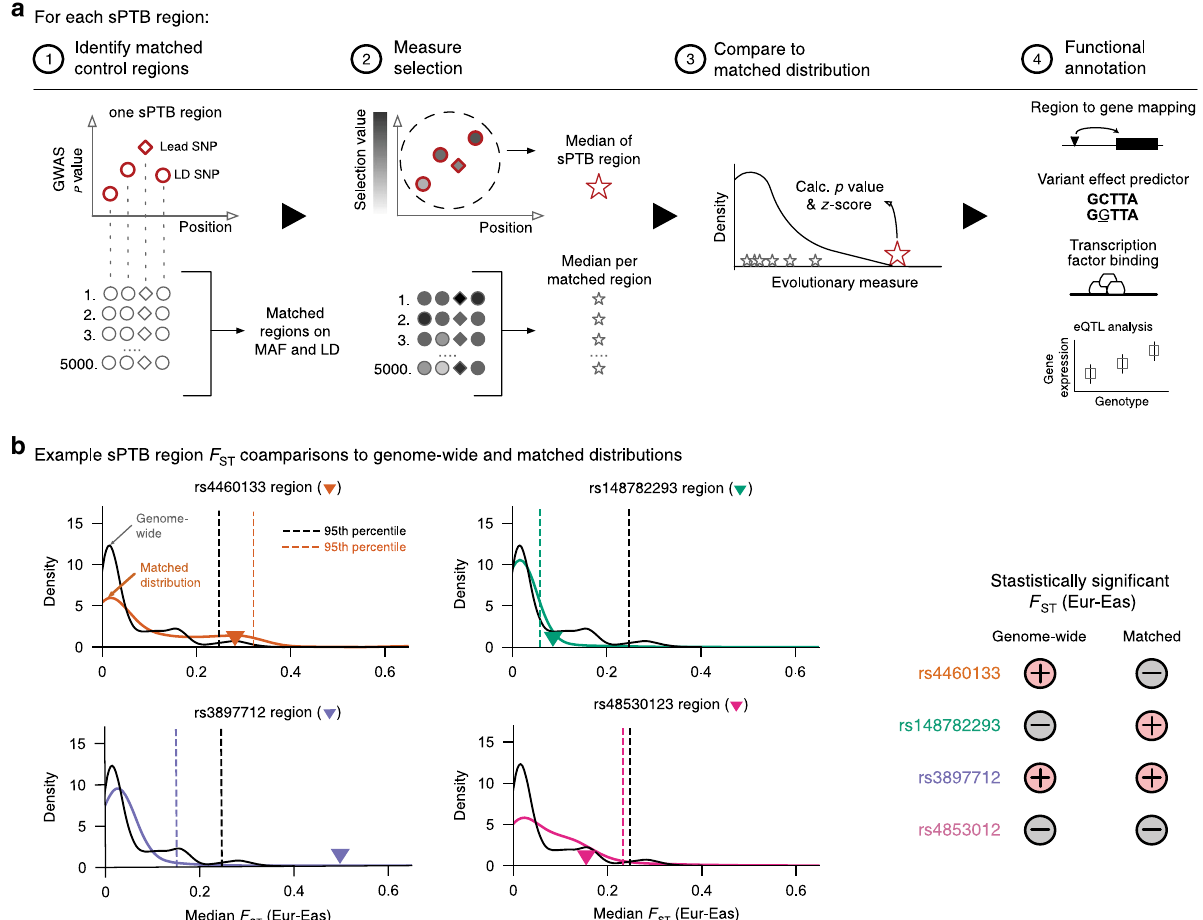
Fig. 1 Framework for identifying genomic regions that have experienced diverse evolutionary forces. a We compared evolutionary measures for each sPTB-associated genomic region ( n = 215) to ~5000 MAF and LD-matched control regions. The sPTB-associated genomic regions each consisted of a lead variant ( p < 10E-4 association with sPTB) and variants in high LD ( r 2 > 0.9) with the lead variant. Each control region has an equal number of variants as the corresponding sPTB-associated genomic region and is matched for MAF and LD ( ‘ Identify matched control regions ’ ). We next obtained the values of an evolutionary measure for the variants included in the sPTB-associated regions and all control regions ( ‘ Measure selection ’ ). The median value of the evolutionary measure across variants in the sPTB-associated region and all control regions was used to derive an empirical p value and z-score ( ‘ Compare to matched distribution ’ ). We repeated these steps for each sPTB-associated region and evolutionary measure and then functionally annotated sPTB- associated regions with absolute z-scores ≥ 1.5 ( ‘ Functional annotation ’ ). b Representative examples for four sPTB-associated regions highlight differences in the distribution of genome-wide and matched control regions for an evolutionary measure (F ST between Europeans and East Asians). The black and colored distributions correspond to genome-wide and matched distributions, respectively. The colored triangle denotes the median F ST (Eur-Eas) for the sPTB-associated region. The dashed vertical lines mark the 95th percentile of the genome-wide (black) and matched (colored) distributions. If this value is greater than the 95th percentile, then it is considered signi fi cant ( + ); if it is lower than the 95th percentile it is considered not-signi fi cant ( − ). The four examples illustrate the importance of the choice of background in evaluating signi fi cance of evolutionary metrics (table to the